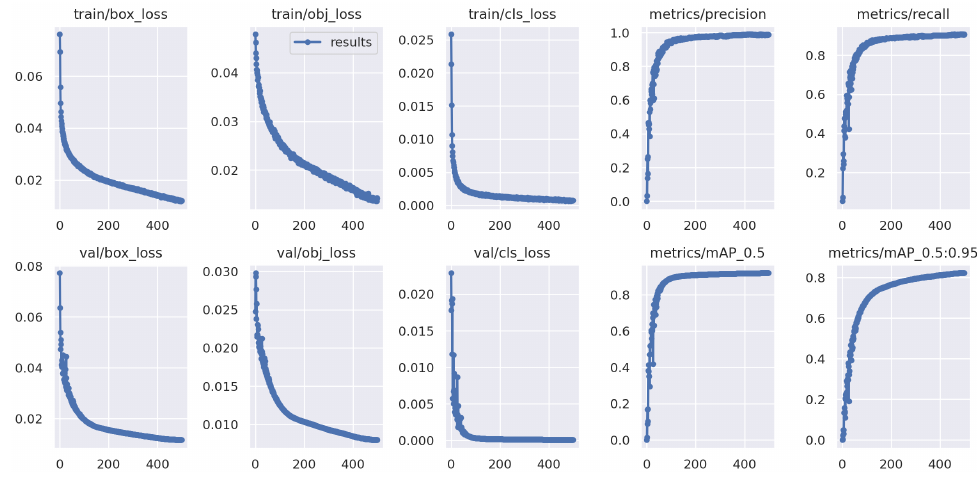
Figure 16. Loss function and training